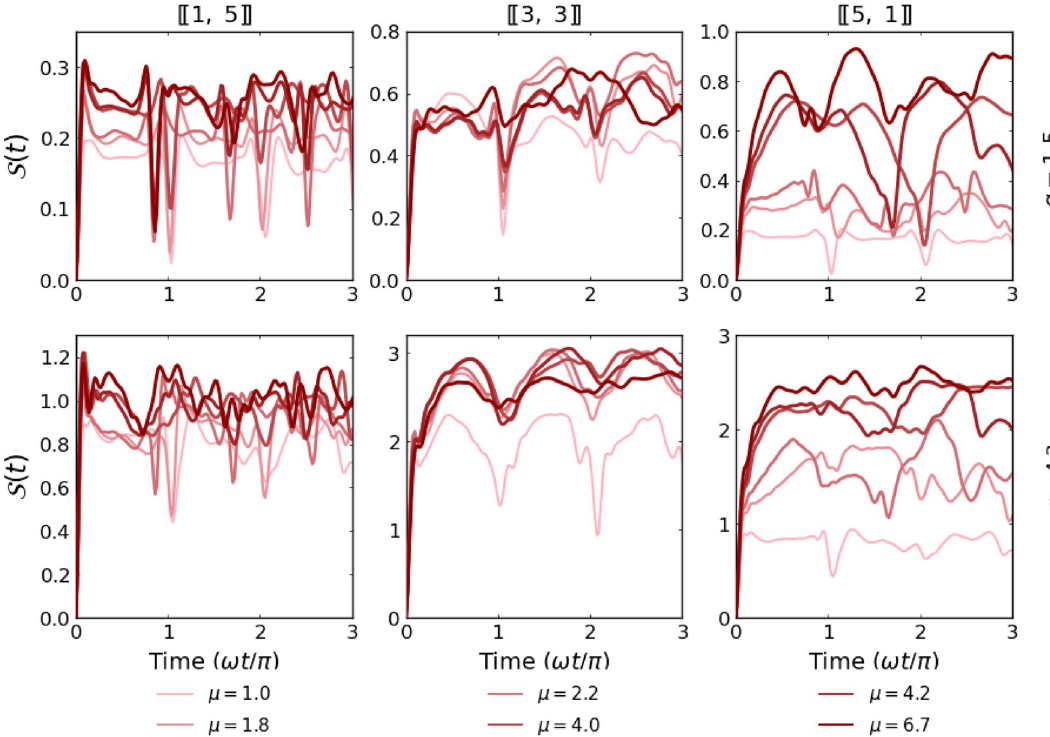
Figure 7. Time evolution of the von Neumann entropy S ( t ) quantifying inter-component correlations in systems of six particles obtained for different mass ratios and different interactions. As one can see, the 1, N correlation produced in system is much smaller than the other two six-particle systems at the same [[ ↓ ]] quench strength. Further, the system with a single impurity manifests stronger dependence on the mass imbalance when compared to the balanced case.